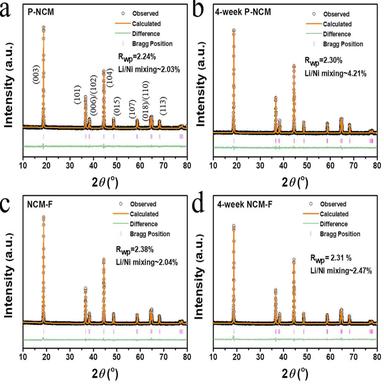
XRD patterns and Rietveld refinement results of (a) P-NCM, (b) 4-week P-NCM, (c) NCM–F, and (d) 4-week NCM–F, respectively.